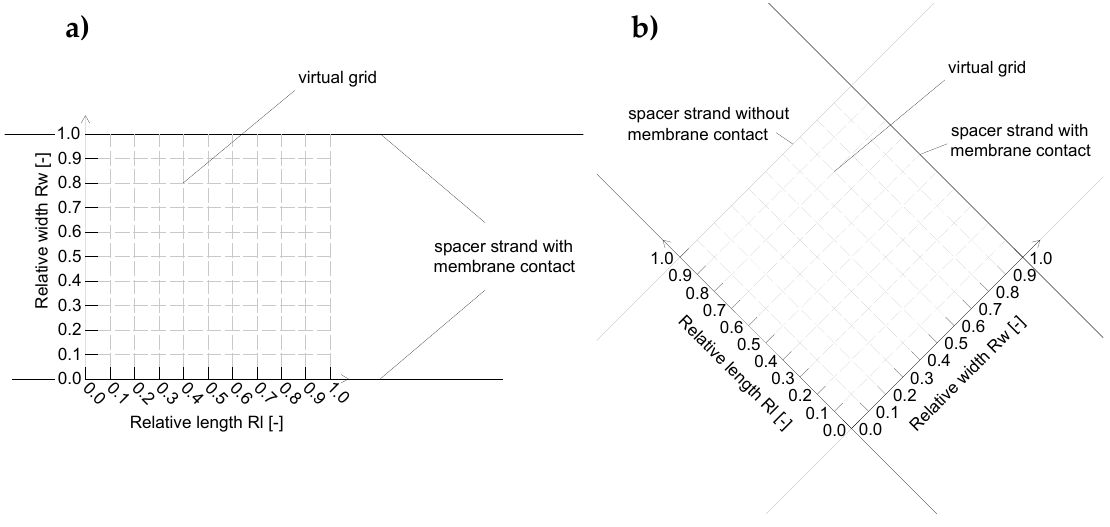
Figure 4. Analysis pattern on the membrane surface for the parallel spacer ( a ) and the diamond spacer ( b ). The 10 × 10 elements virtual grid was used to analyze the deposition intensities spatially resolved in the various positions between the spacer strands and ribs, respectively.